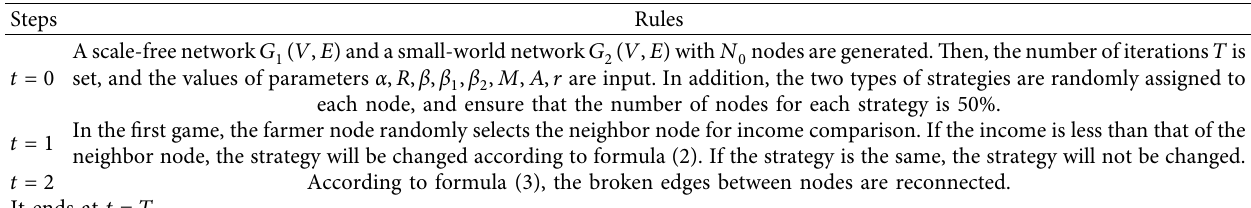
Table 3: Evolutionary game